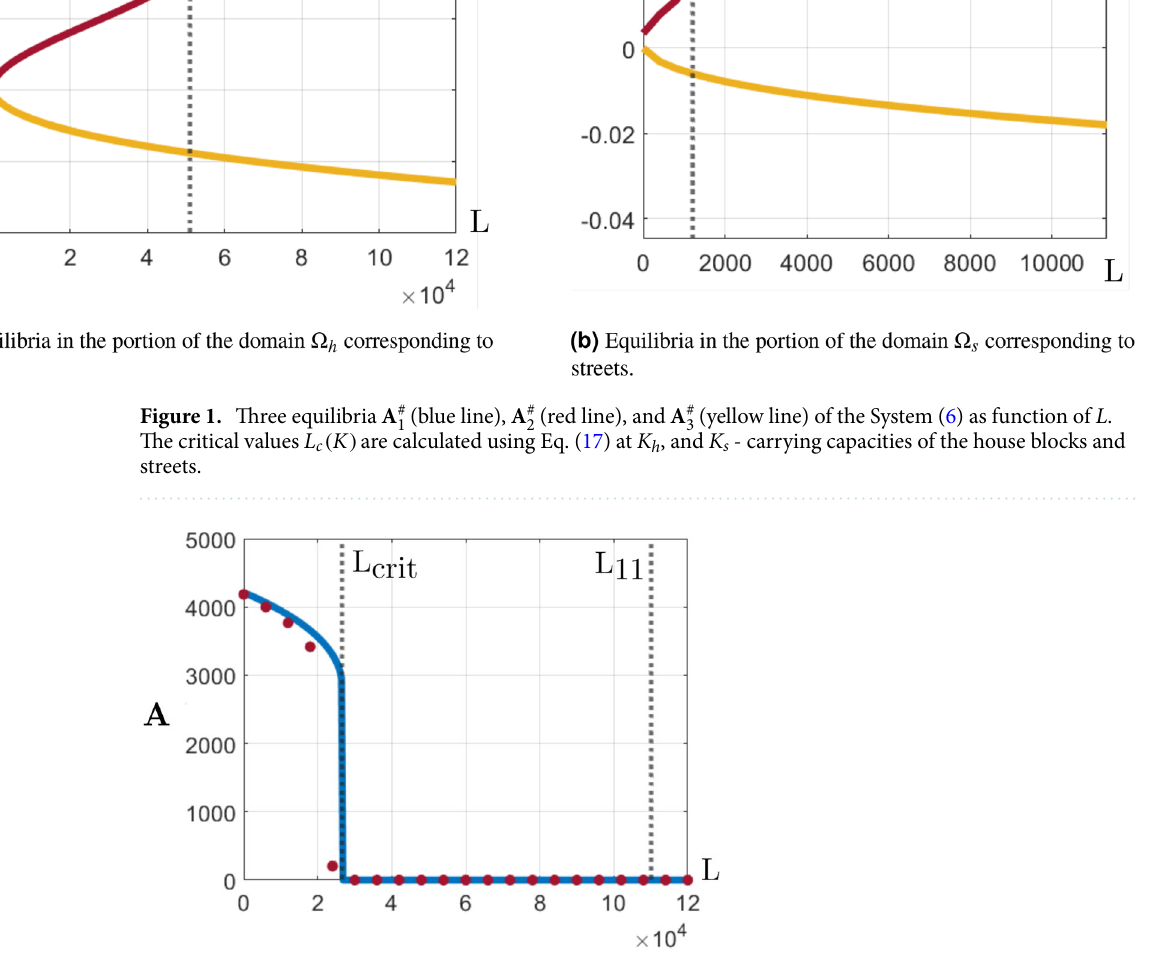
# 1 at each grid block) as a